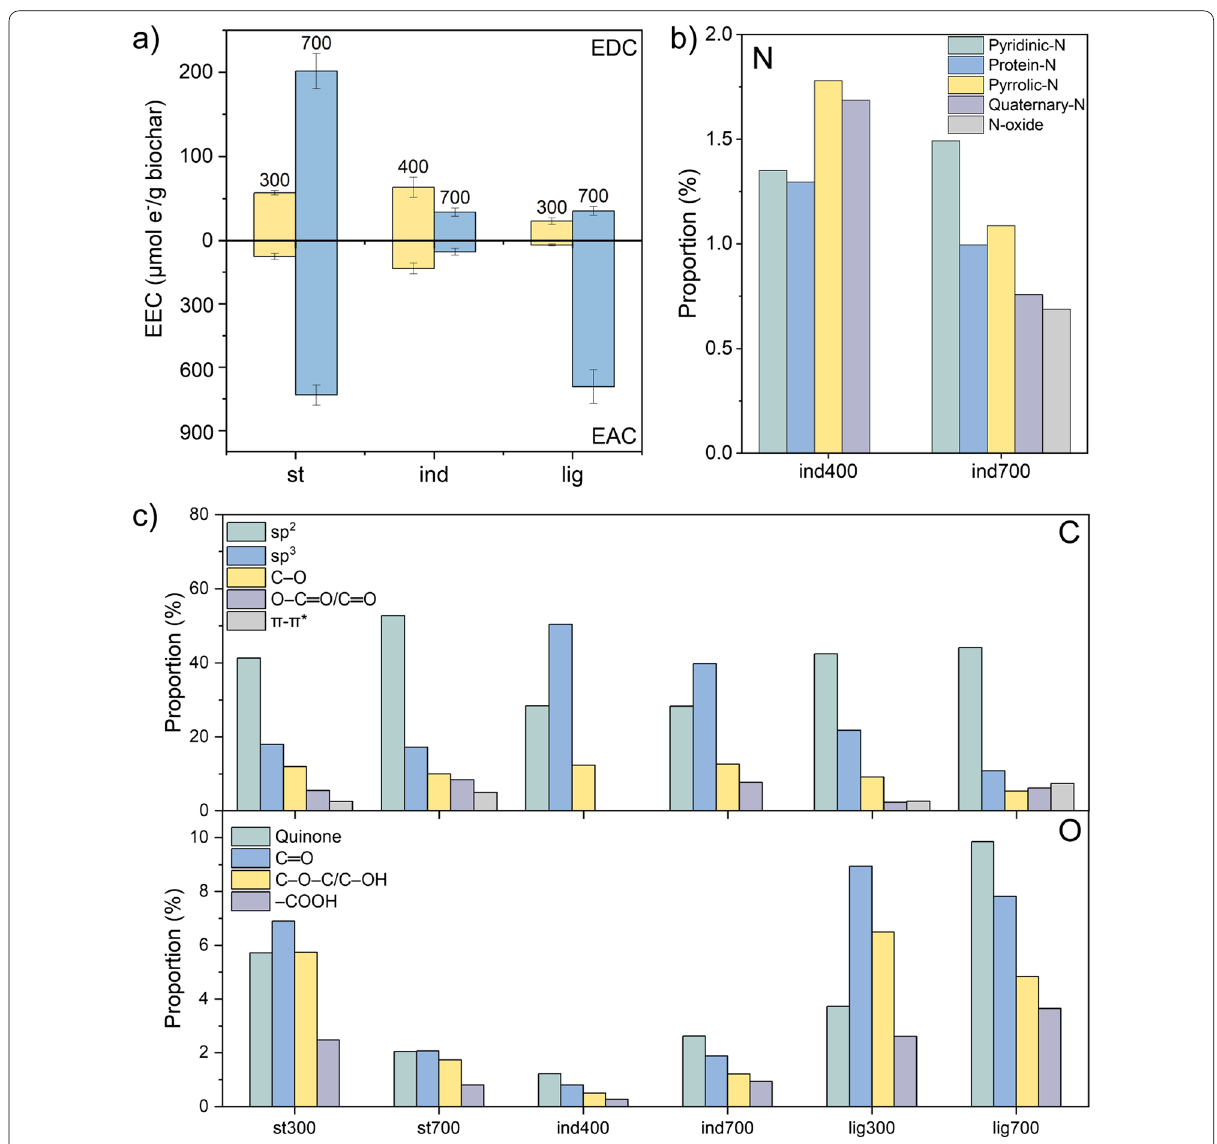
Fig. 1 EEC and surface functional groups of chars. a EEC b N bonding categories c C and O bonding categories “st”, “ind”, and “lig” represent the chars derived from starch, indigo dye, and lignin, respectively. The labels over the columns in a and number suffixes in b , c represent pyrolysis temperature. (The XPS data of starch dervied chars and lignin-derived chars were cited from our previous publication (Li et al.